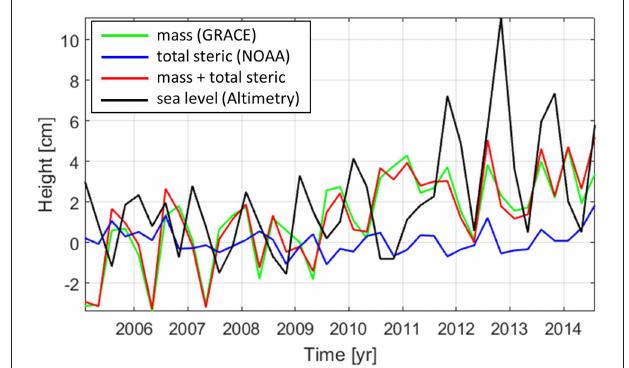
FIGURE 8 | Three-month sea level variation from Altimetry (black) and EWT from GRACE (green), steric contribution (blue), and the sum of ocean mass (GRACE) with steric height (red). All values are in